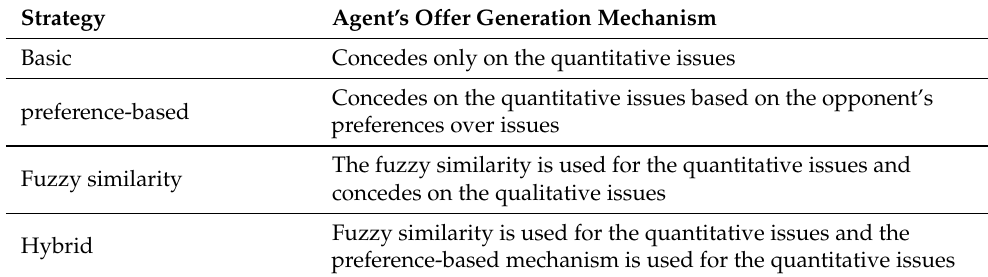
Table 2. Negotiation